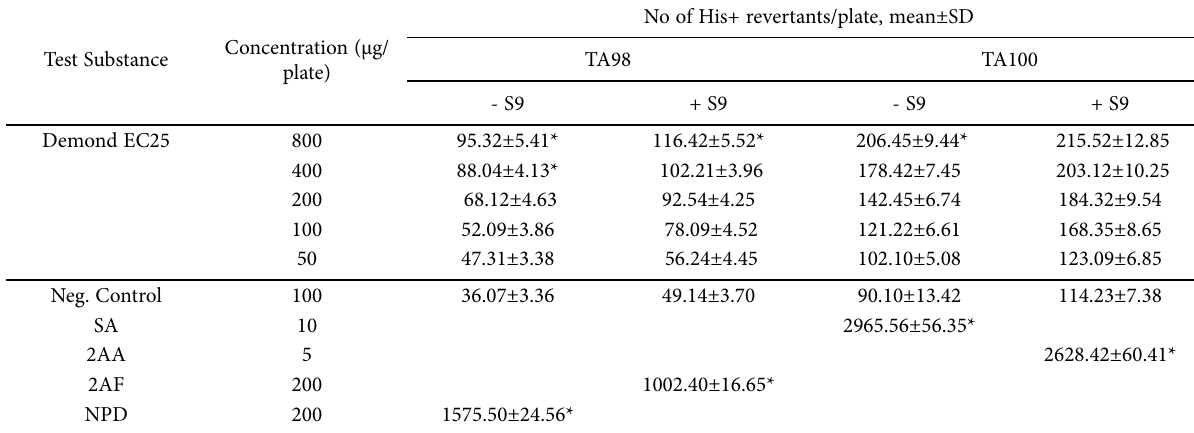
Table 3.The mutagenicity assay results of Demond EC25 for S. tyhimurium TA98 and TA100 strains